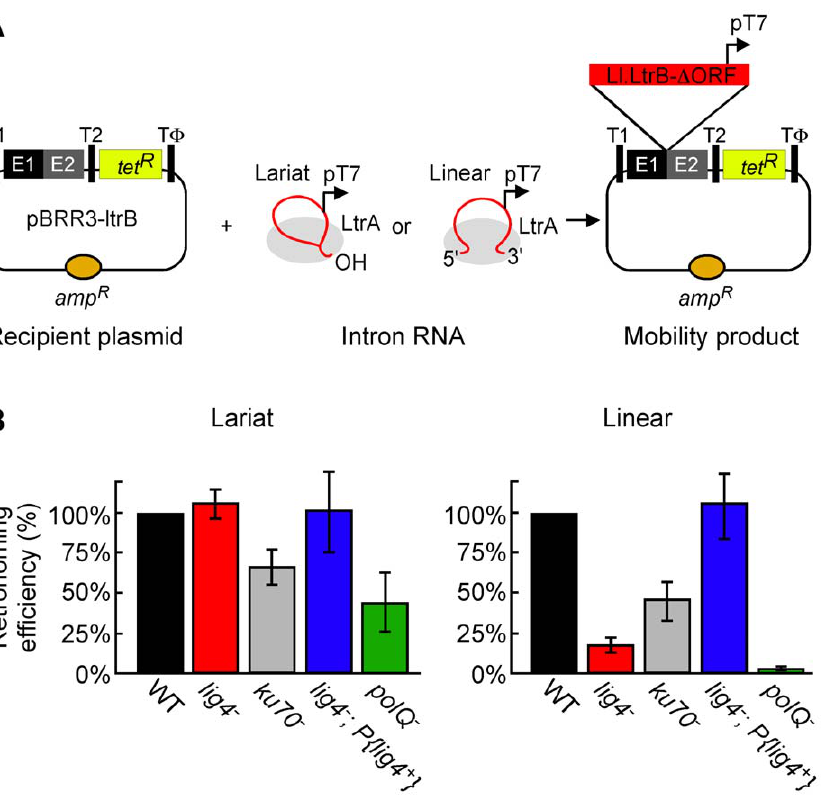
Figure 2. Retrohoming efficiencies of linear and lariat group II intron RNAs in wild-type and mutant Drosophila . (A) Microinjection assay for retrohoming of lariat and linear group II intron RNAs. D. melanogaster precellular blastoderm are microinjected with the Amp R -recipient plasmid pBRR3-ltrB, which contains an Ll.LtrB target site (ligated E1–E2 sequence) cloned upstream of a promoterless tet R gene, followed by separate microinjection of Ll.LtrB RNPs containing linear or lariat intron RNAs with a phage T7 promoter sequence inserted near their 3 9 end. The embryos are incubated at 30 u C for 1 h, during which the intron integrates into the target site in the recipient plasmid, placing the T7 promoter upstream of the promoterless tet R gene. Nucleic acids are then extracted and transformed into E. coli HMS174(DE3) for plating assays, and retrohoming efficiencies are calculated as the ratio of (Tet R + Amp R )/Amp R colonies. T1 and T2, E. coli rrnB transcription terminators; T w , phage T7 transcription terminator. (B) Retrohoming efficiencies of lariat and linear Ll.LtrB RNPs in D. melanogaster wild-type ( w 1118 and Or-R) and mutant embryos were determined, as described in panel A and Materials and Methods. The bar graphs show retrohoming efficiency in the indicated mutant embryos relative to that of wild-type embryos assayed in parallel in ten independent experiments with different combinations of strains (Table S1). The values are the mean for at least three independent determinations for each mutant, with the error bars indicating the standard error. The retrohoming efficiency of # 0.5% wild type for linear RNPs in the polQ mutant is an upper limit, as only a single Tet R + Amp R colony was recovered in three separate experiments, although 5 9 -intron integration junctions could be detected by using a more sensitive PCR assay in all experiments (see Figure 3).